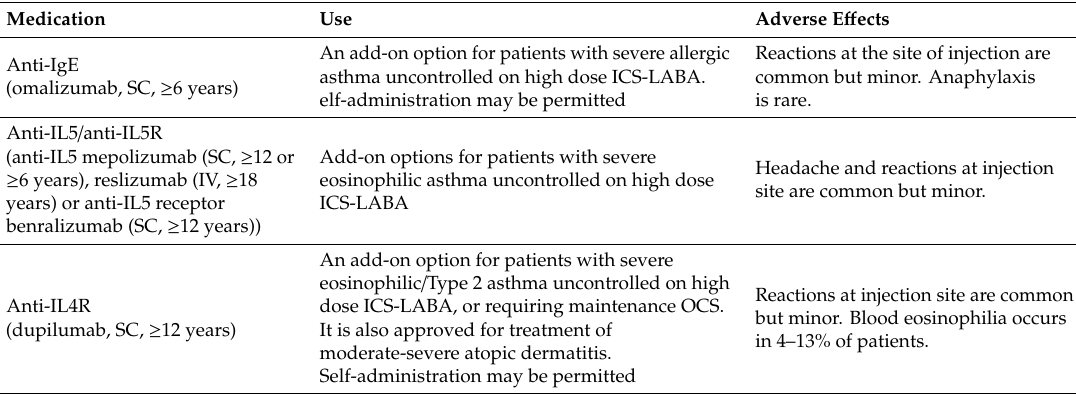
Figure 10. Criteria for the choice of biologic as add on treatment in Th2 driven severe asthma. Table 6. Currently available biologics: indications and adverse e ff